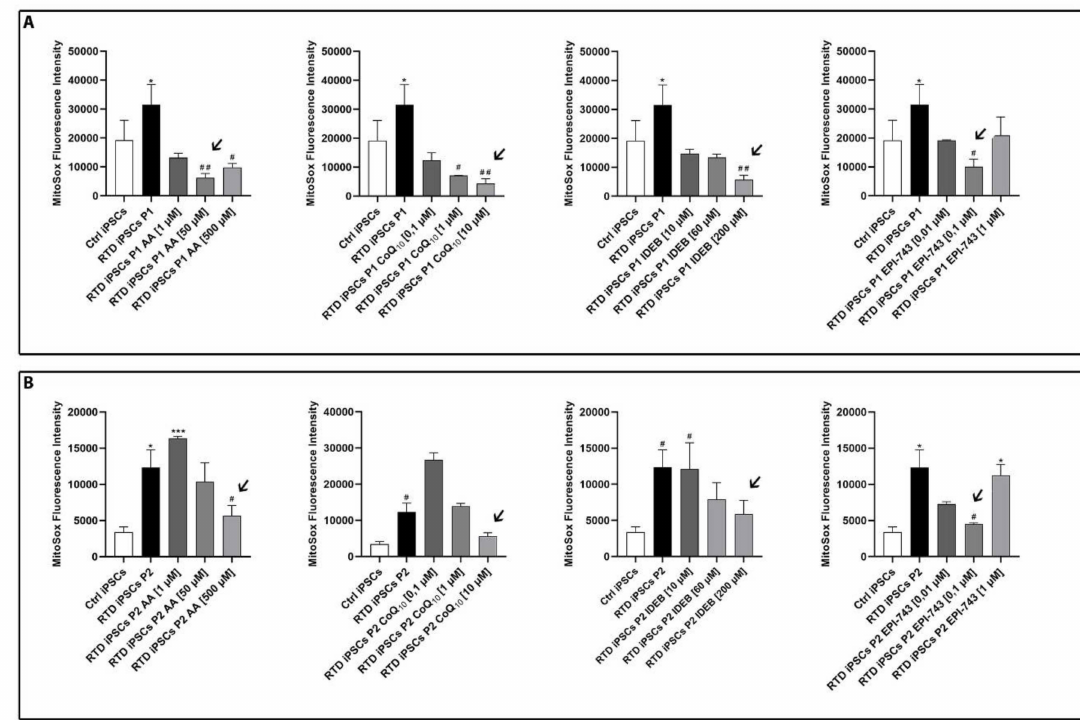
Figure 1. Quantification of superoxide anion in riboflavin transporter deficiency (RTD) induced pluripotent stem cells (iPSCs) following treatment with antioxidants ascorbic acid (AA), CoQ 10 , Idebenone, and EPI-743, showing their e ff ect on RTD iPSCs superoxide anion production. For each RTD cell line, P1 ( A ) and P2 ( B ), the arrows indicate the antioxidant concentration most e ff ective in